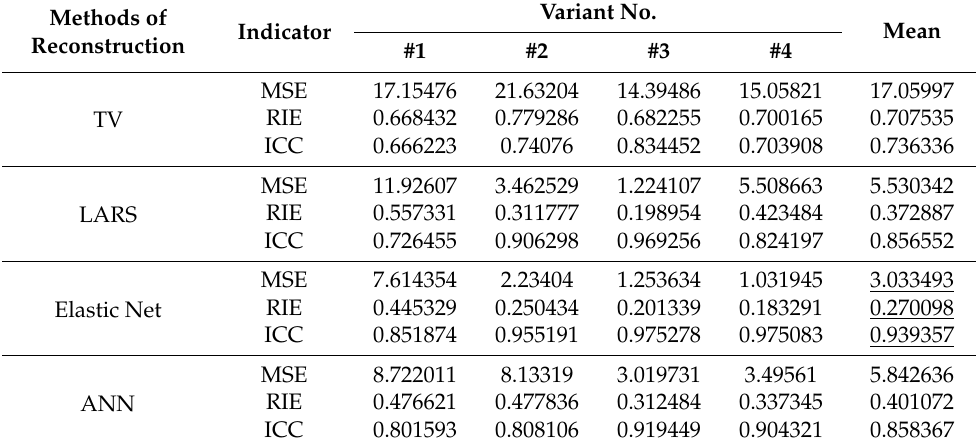
Table 5. Indicators characterizing the quality of reconstruction for individual methods and